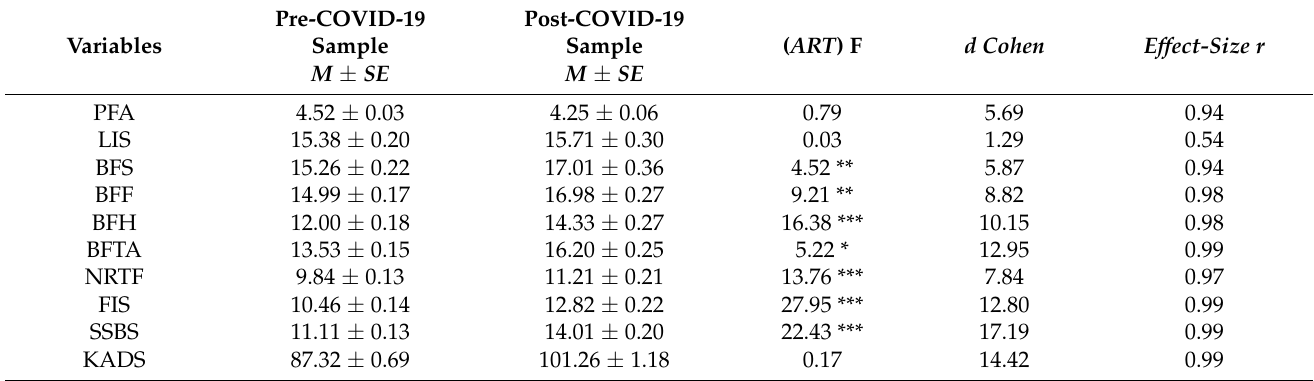
Table 4. Comparison of psychological characteristics between pre-COVID-19 ( n = 355) and post- COVID-19 ( n = 313) samples: ( ART ) F statistic results.